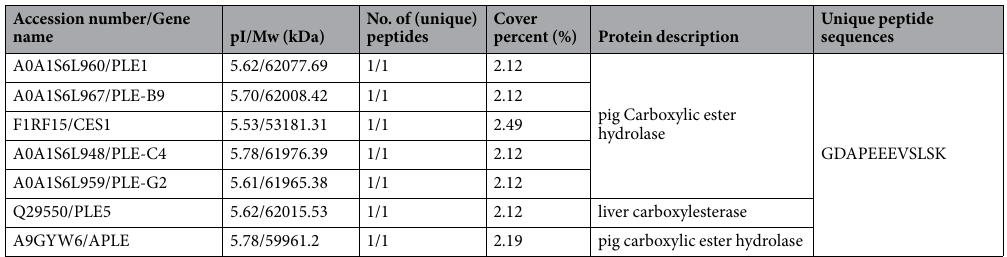
Table 1. The information of PLE proteins in pig serum by shotgun proteomic